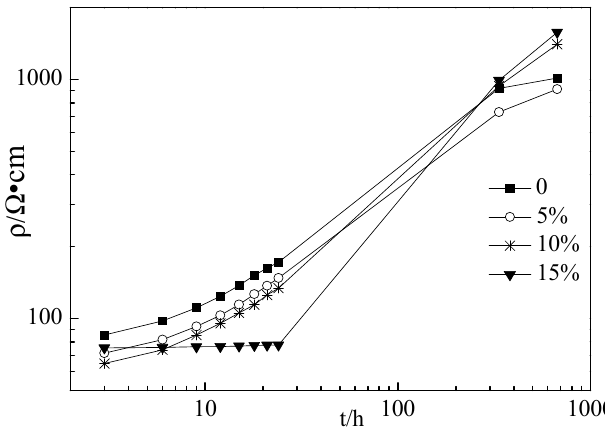
Figure 3. Electrical resistivity of specimens with w/c ratio of 0.40.